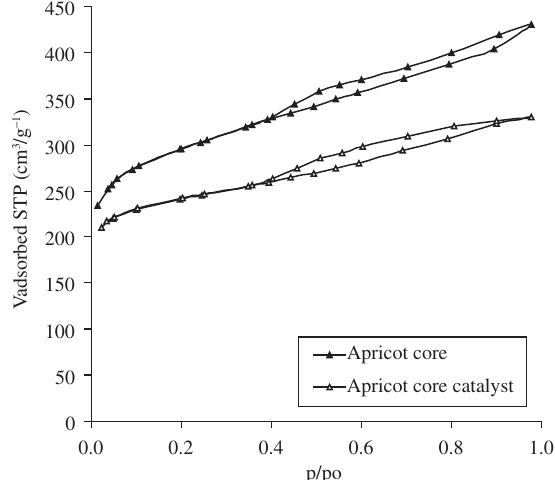
Figure 1. Nitrogen adsorption-desorption isotherms (77 K) for apricot core AC support and catalyst.